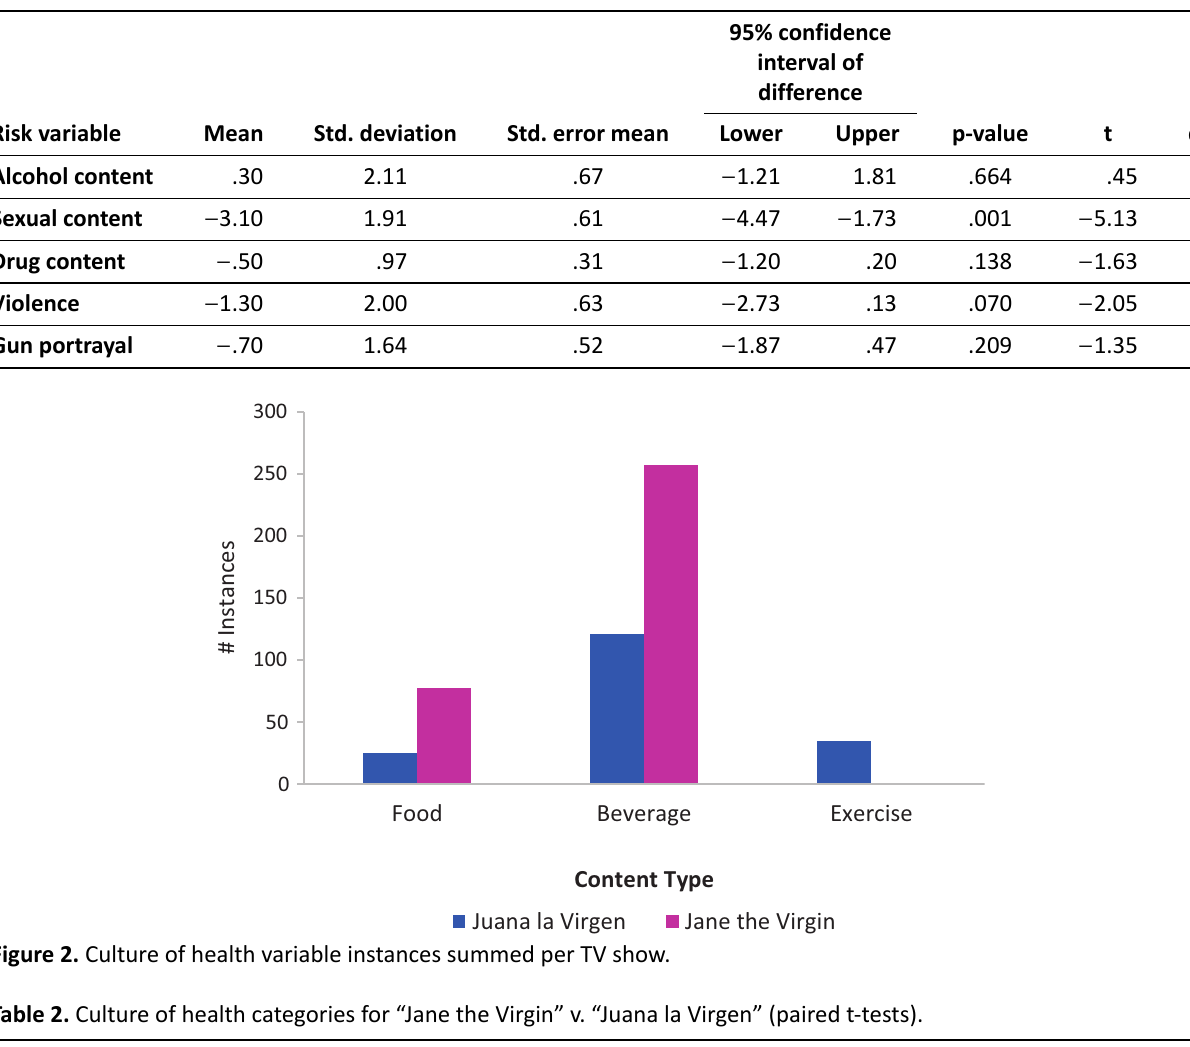
Table 1. Risk categories for “Jane the Virgin” v. “Juana la Virgen” (paired t-tests).